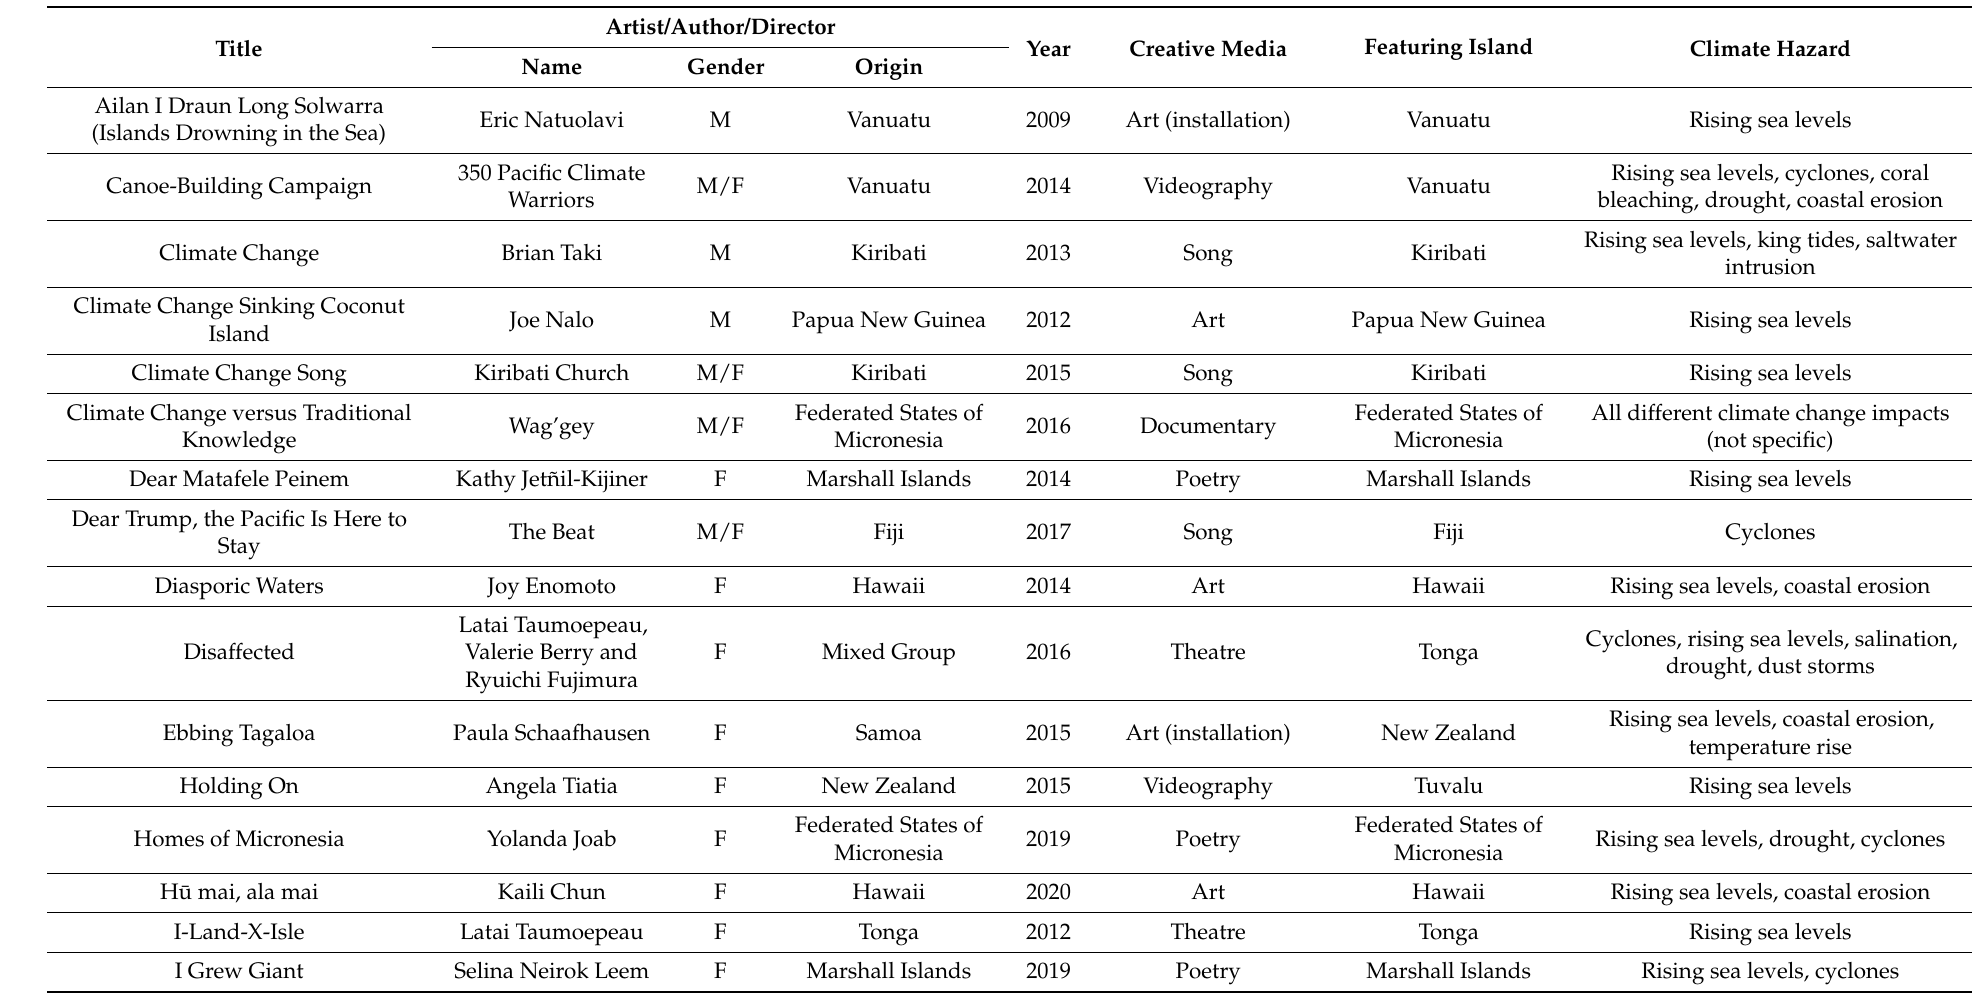
Table A1. Full list of creative works analysed as part of this